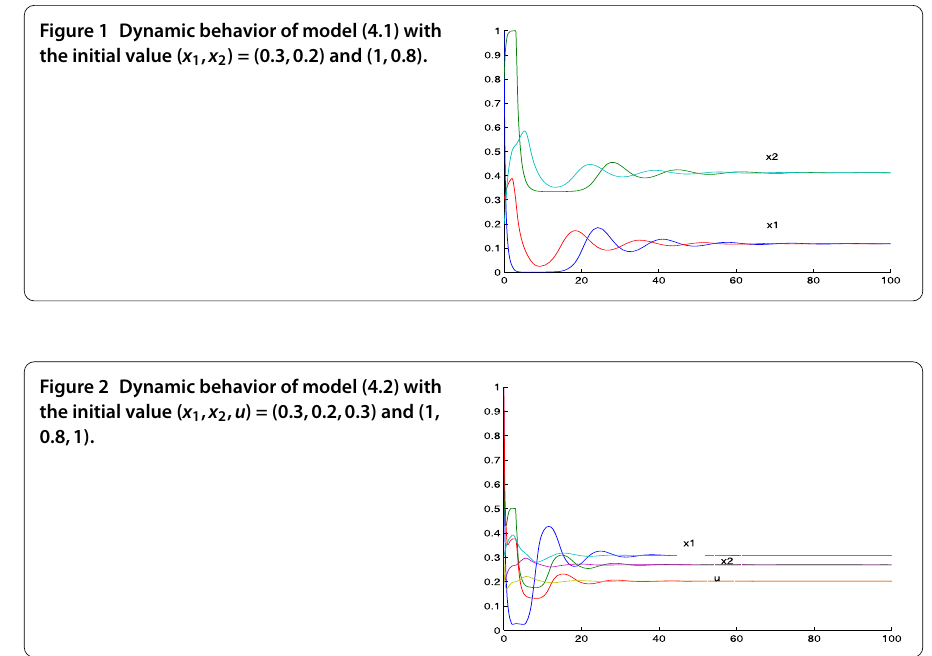
Figure 2 Dynamic behavior of model (4.2) with the initial value ( x 1 , x 2 , u ) = (0.3,0.2,0.3) and (1,